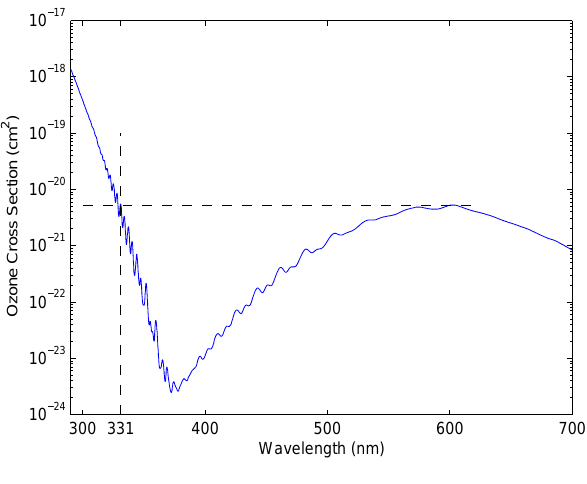
Fig. 3. Typical ozone absorption cross section. The value is similar at 331nm and 602nm.